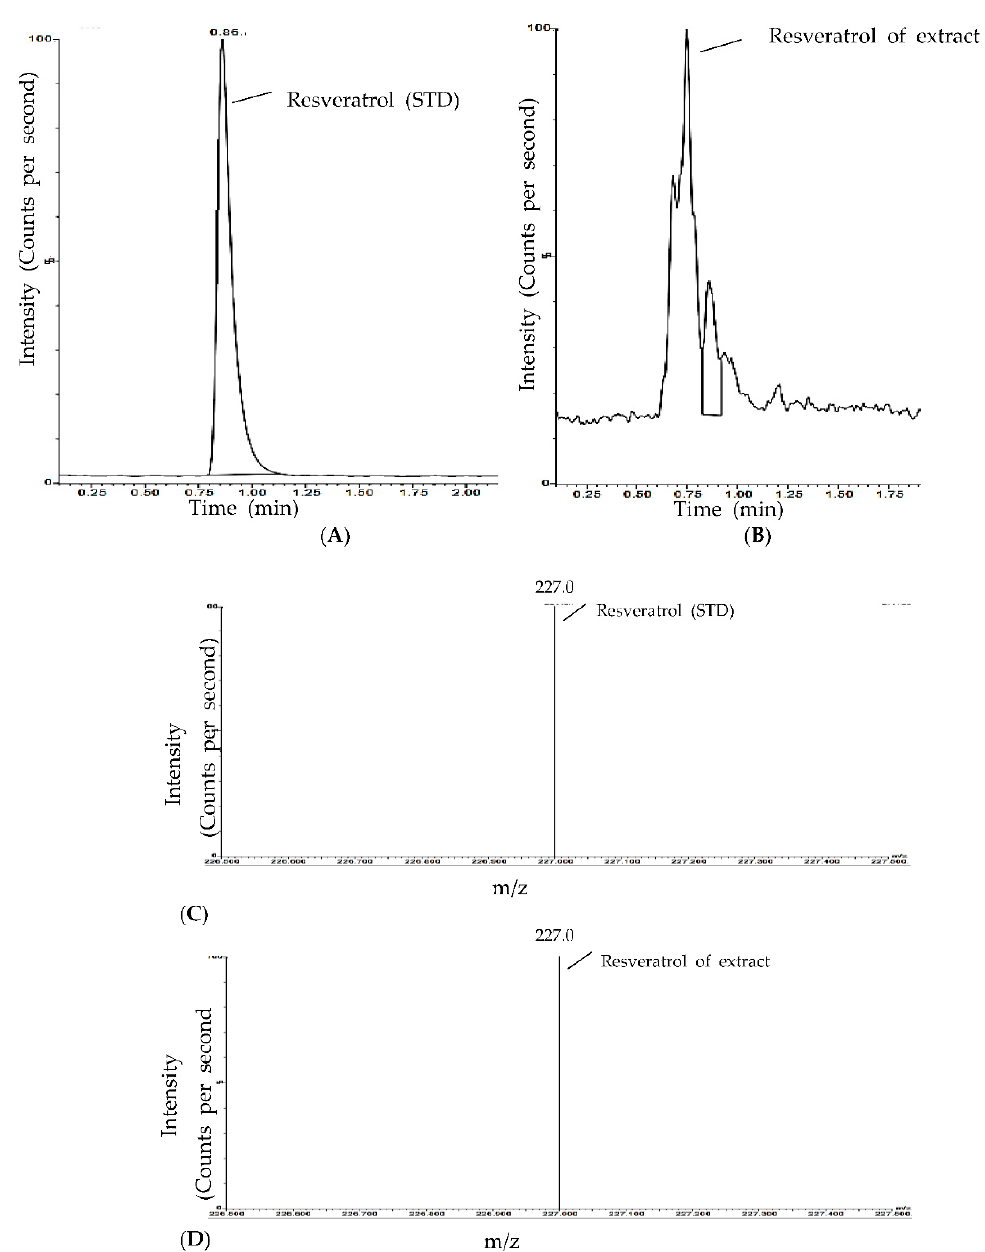
Figure 3. Separation of resveratrol by a liquid chromatography-mass spectrometry (LC-MS) analysis. ( A ) Representative chromatogram of resveratrol standards. ( B ) Representative chromatogram of resveratrol containing an extract obtained from peanut sprouts grown under blue LED light. MS spectra of ( C ) standard resveratrol. ( D ) MS spectra of resveratrol from peanut extracts (blue LED). Optical density: UV detector at 306 nm.